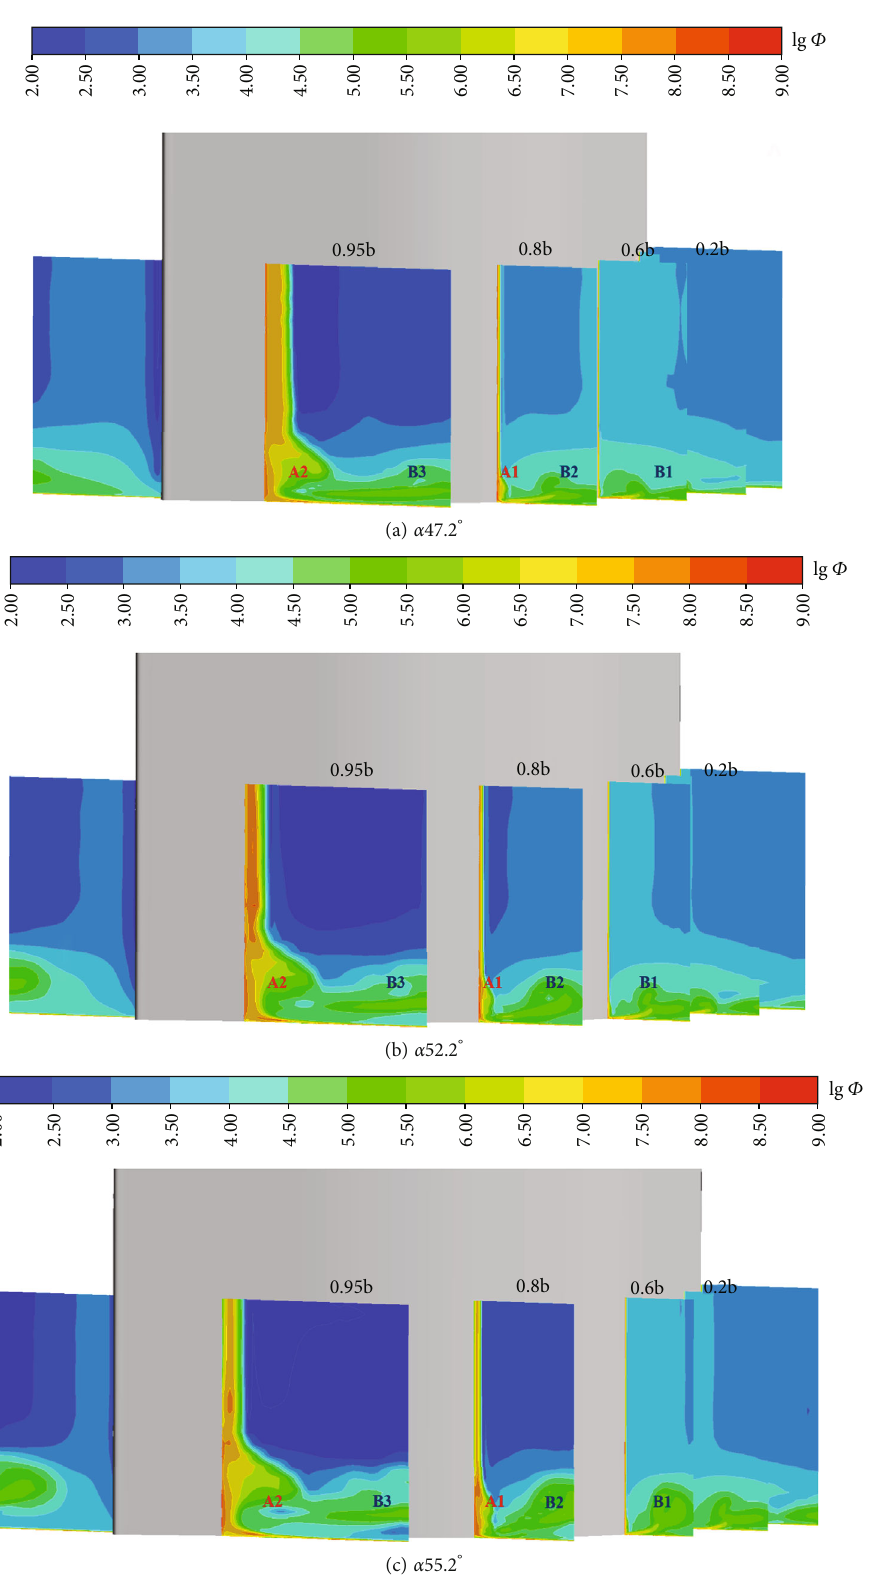
Figure 10: Comparison of dissipation functions for di ff erent stagger